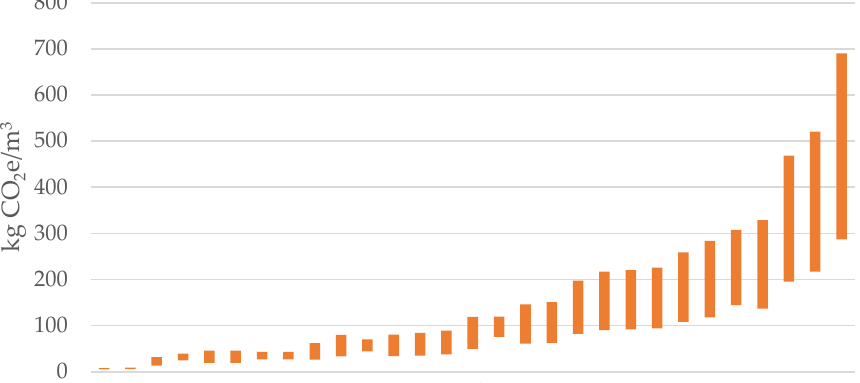
Figure 10. Uncertainty span added to the reported production stage GWP (A1–A3) of timber products. Numbers are adjusted for reported or estimated biogenic CO 2 content.